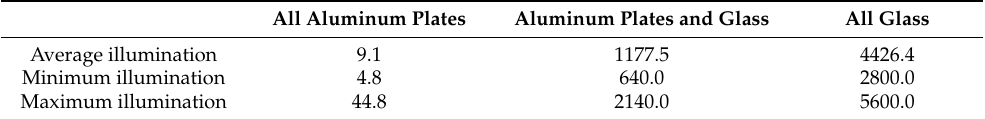
Table 4. Atrium illumination value (lux).